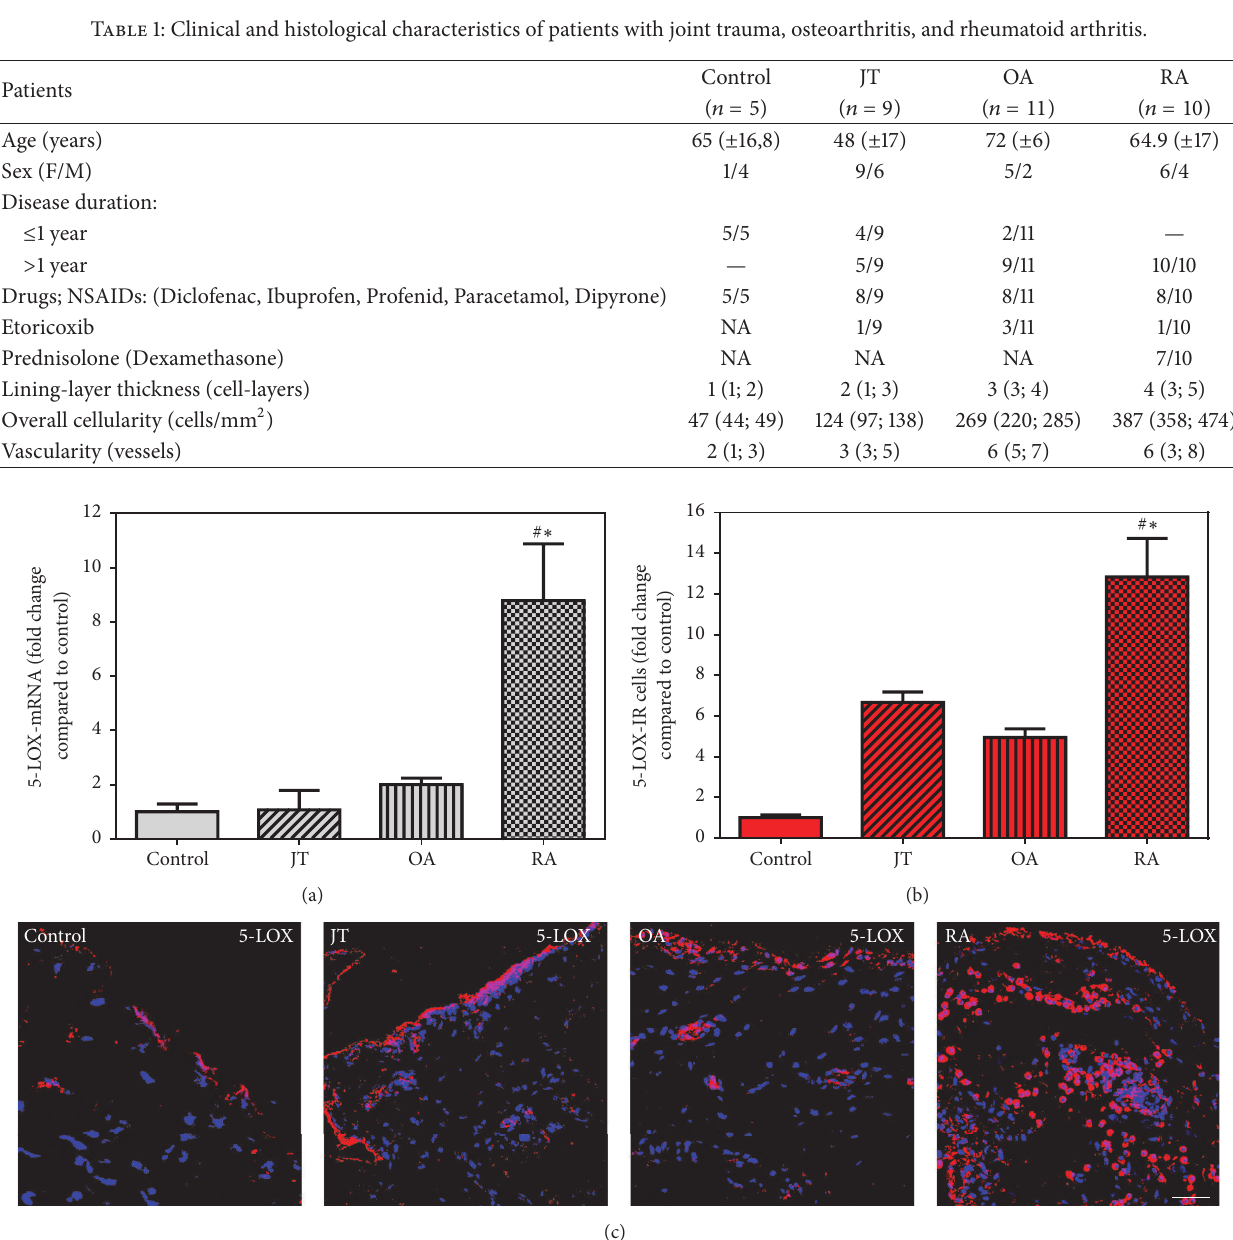
Figure 1: Detection of 5-LOX mRNA (a) and number of 5-LOX-IR cells (b and c) in patients with joint trauma (JT), osteoarthritis (OA), and rheumatoid arthritis (RA). (a) Quantification of 5-LOX mRNA using TaqMan qRT-PCR shows that 5-LOX mRNA was significantly higher in RA compared to JT, OA, and control synovium ( 𝑃 < 0.05 , one-way ANOVA followed by Tukey’s test). (b) Quantitative analysis